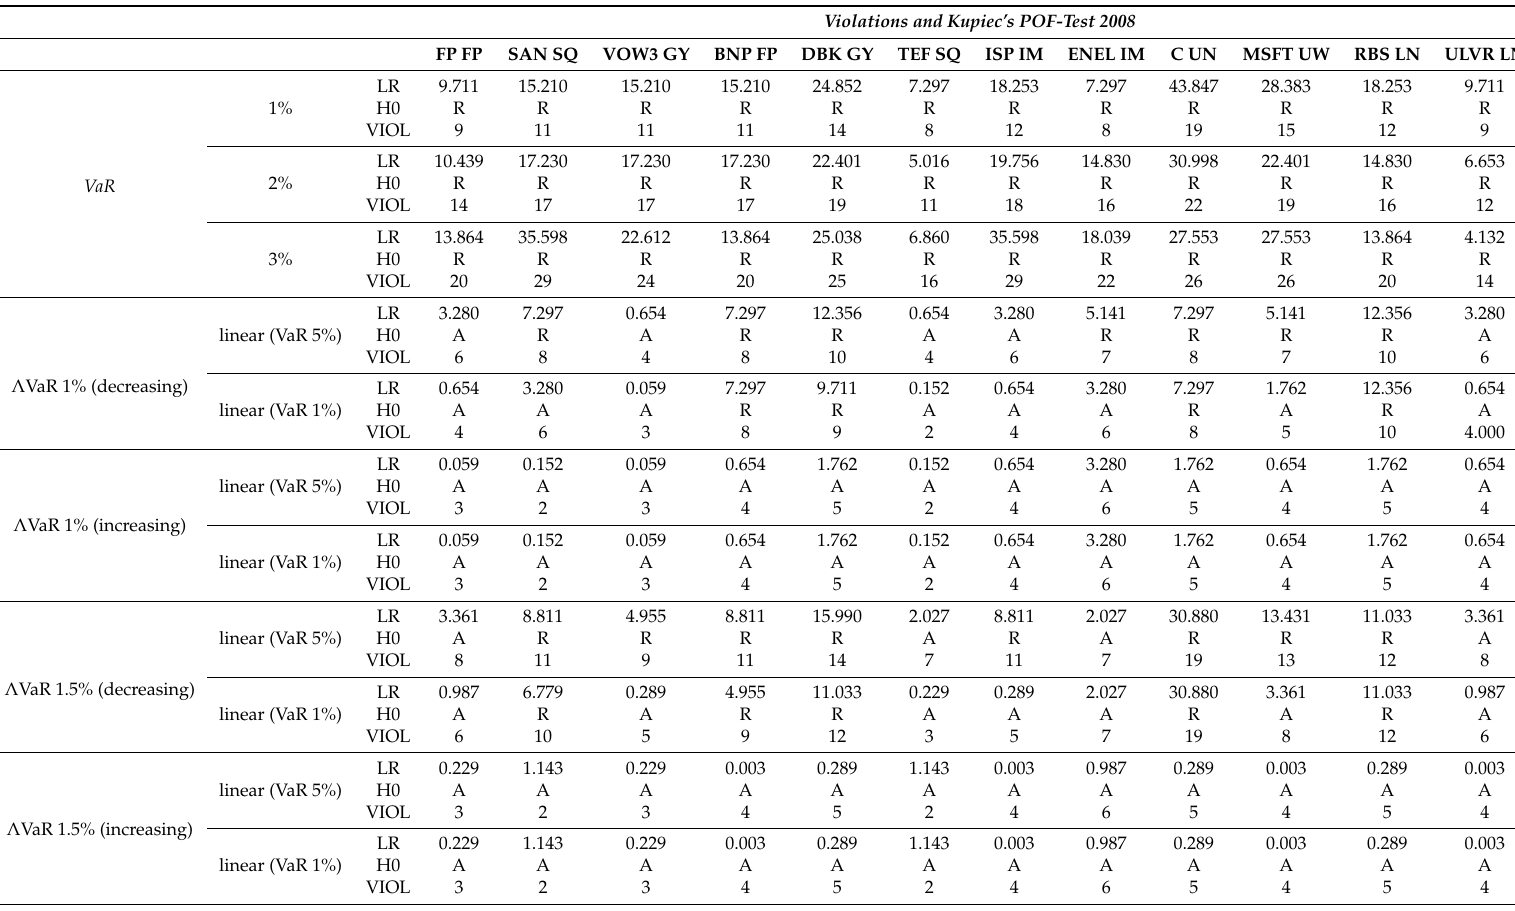
Table A2. Violations and Kupiec’s POF test for each equity and risk model. The table displays the violations, the POF test statistic (log-likelihood ratio, LR), and